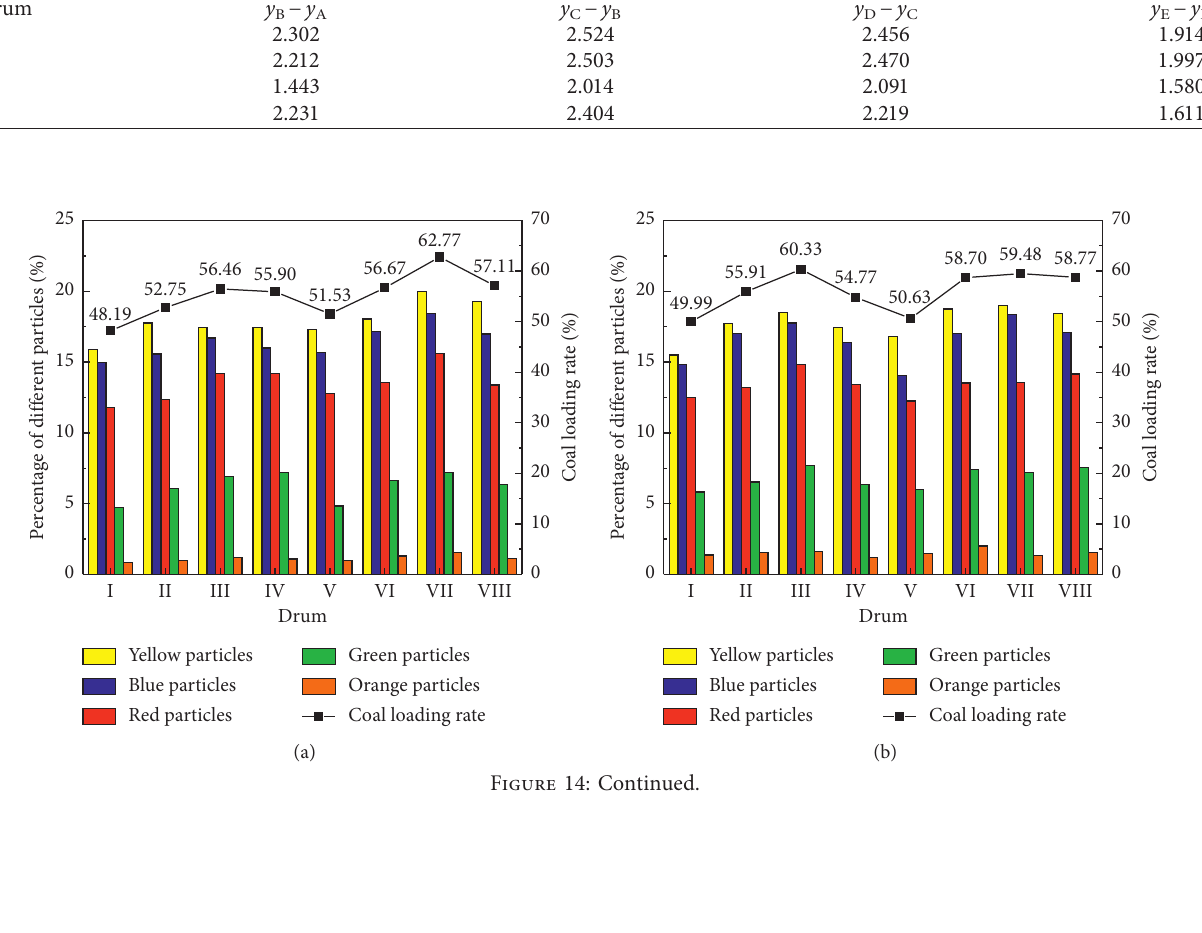
Figure 13: Cumulative mass of coal particles in different statistical areas changes with time at 60rpm: (a) drum I, (b) drum III, (c) drum V, and (d) drum VI. Table 5: The difference of the slope of the cumulative coal particle mass curve in different statistical areas. The difference in the slope of the fitting